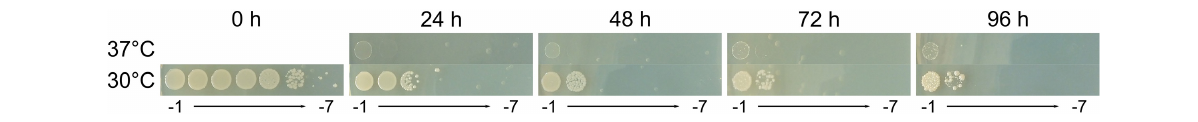
to Tc 20 but sensitive to Km 1500 were further confirmed by sequencing and were designated CH34 (cid:49) 1009, CH34-TIMM R 1 (cid:49) 1009, and CH34-TIMM R 2 (cid:49) 1009. All primers used in this study are listed in Supplementary Table 1